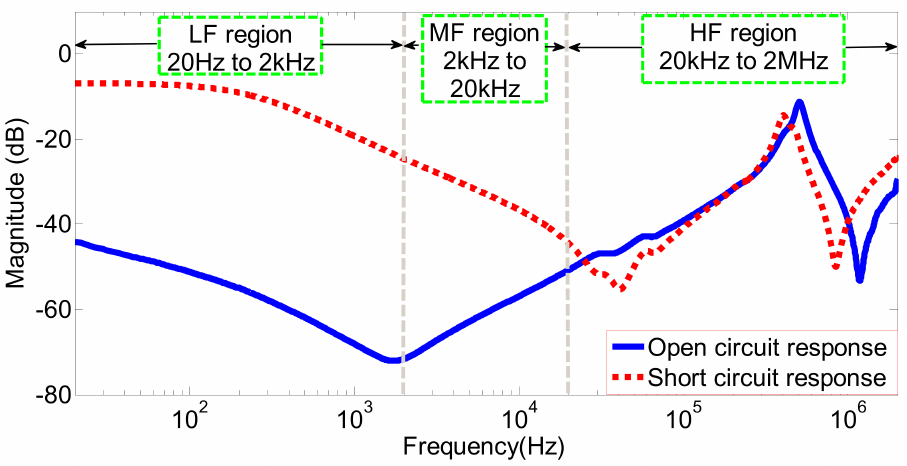
Figure 4. The three typical frequency sub—bands for transformer